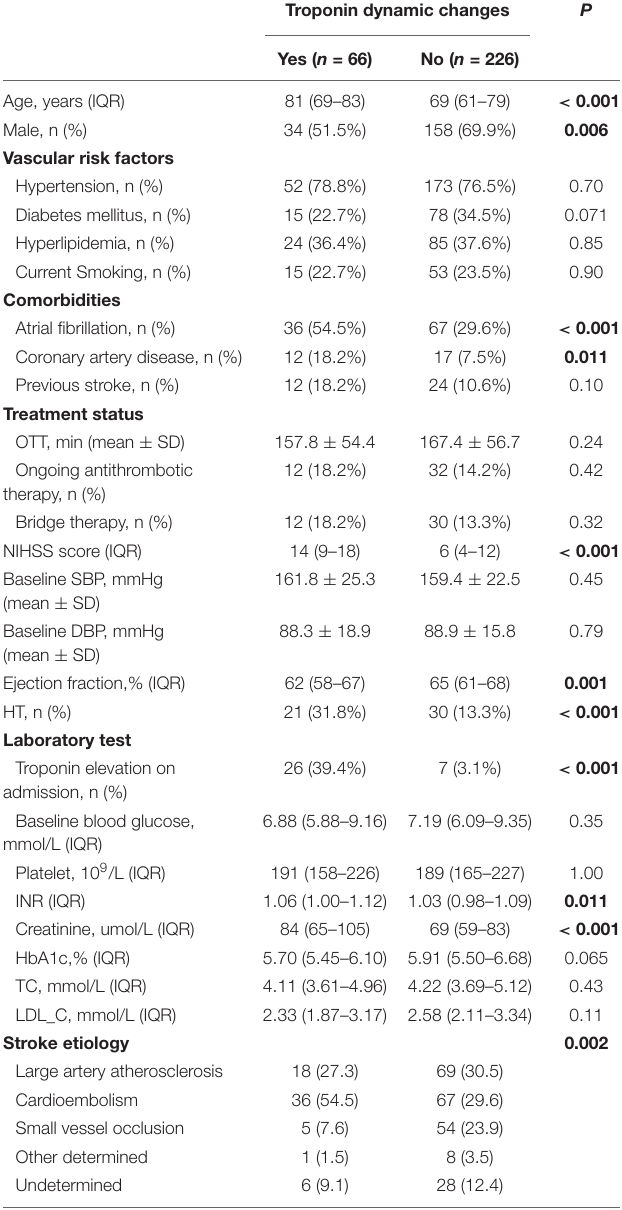
TABLE 1 | Clinical characteristics of patients, stratified by the presence of troponin dynamic